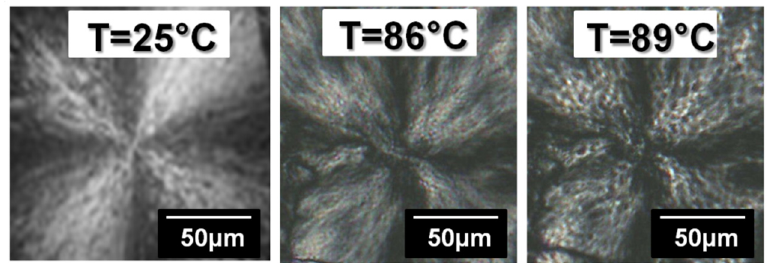
Figure 8. Observation by optical microscopy with a polarized light of PE spherulites melting behaviour.